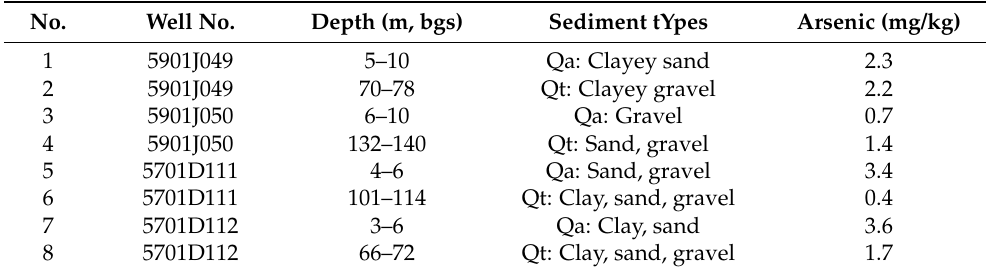
Table 3. Leachable arsenic from